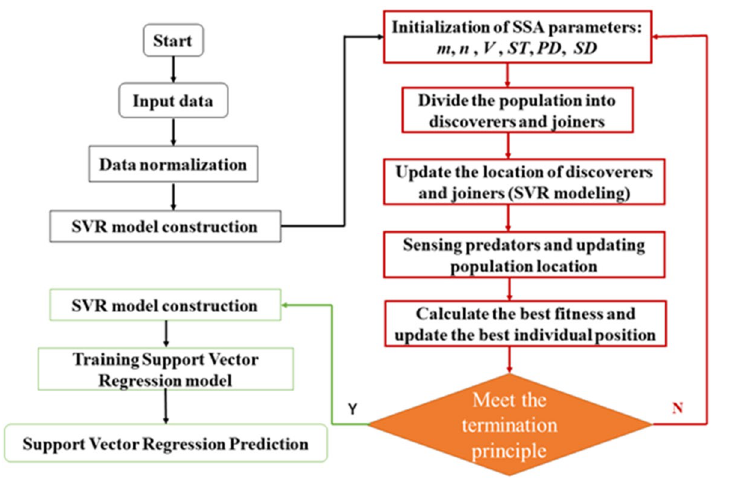
Figure 5. Algorithm flow chart of SSA-SVR.